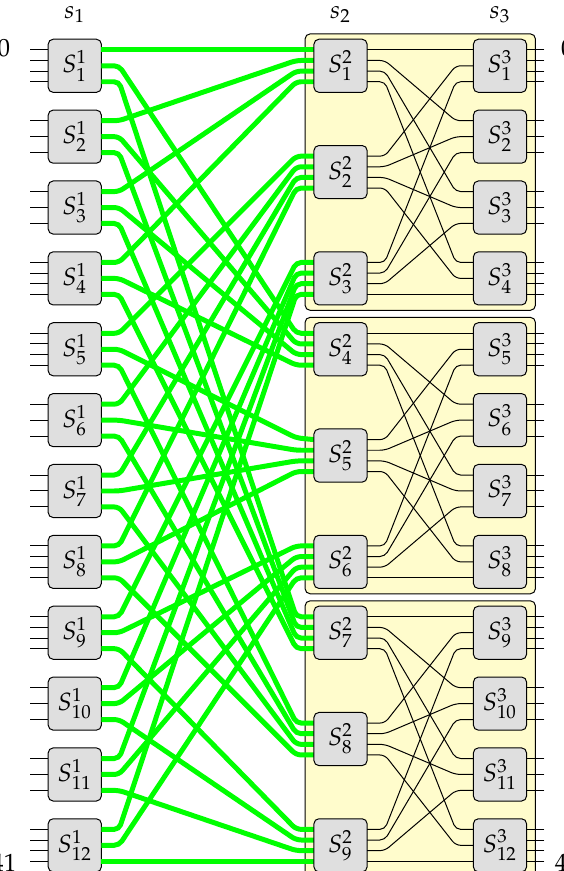
Figure 8. Algorithm 1—step